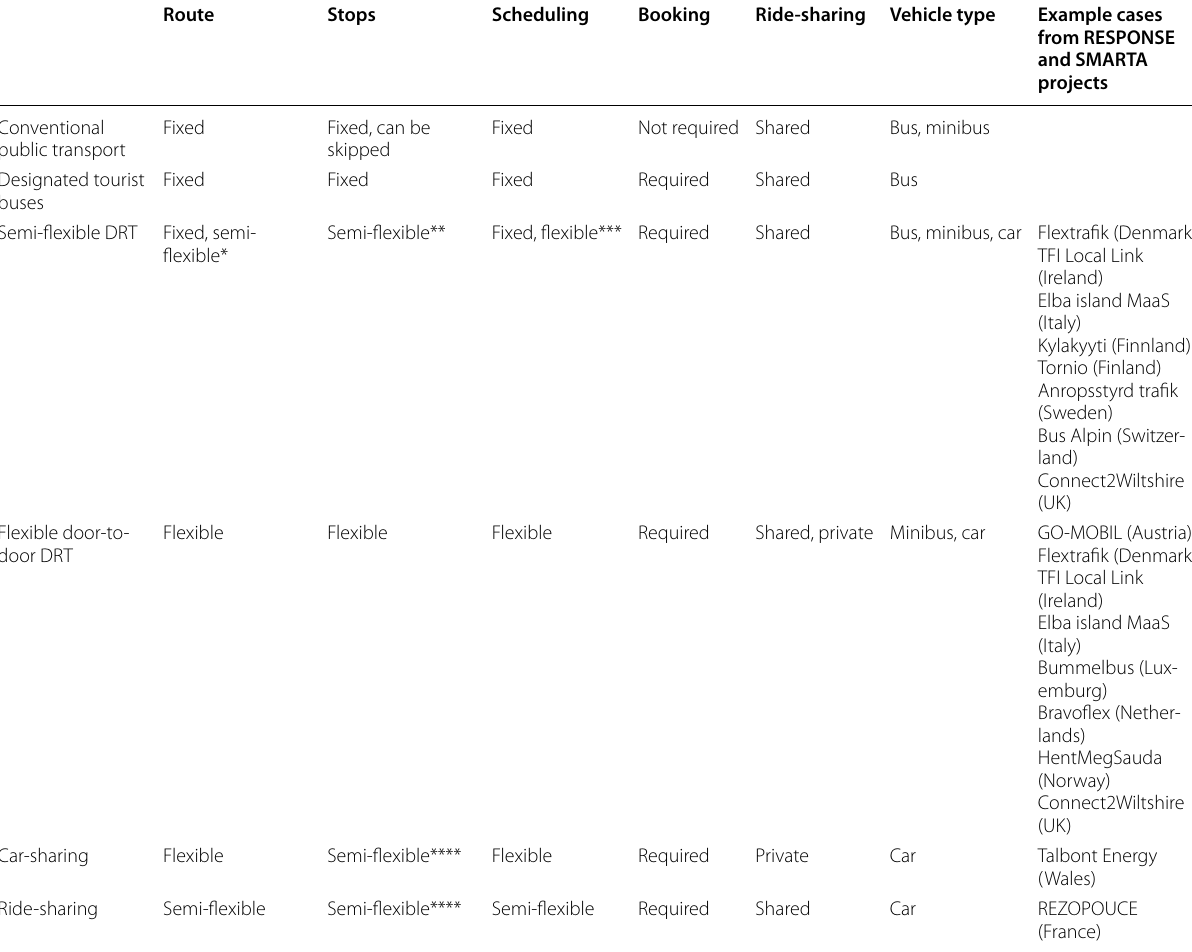
*A route with pre-defined stops that may be skipped and served in a flexible order depending on current demand **Stops may be predefined along a route or in an area and may be skipped and served in a flexible order depending on current demand ***Services that operate both fixed and demand-based schedules depending on the time of day or week ****Depending on pick-up and drop-off